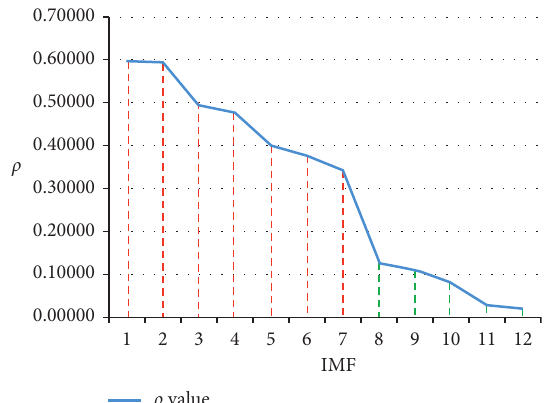
Figure 3: Frequency-domain correlation coefficient of IMF frequency. Table 1: The feature vector used in this work.